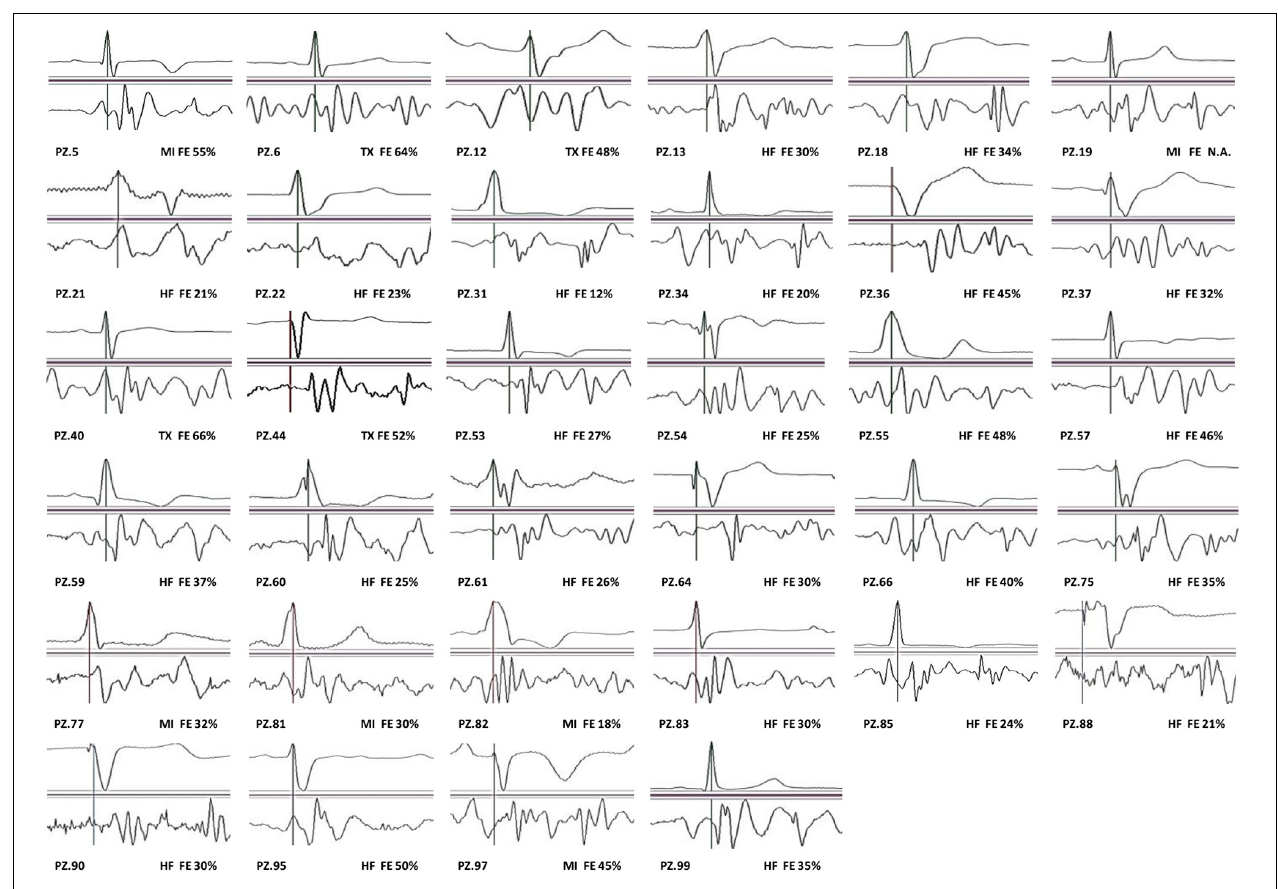
FIGURE 4 | SCG non-traditional (NT)